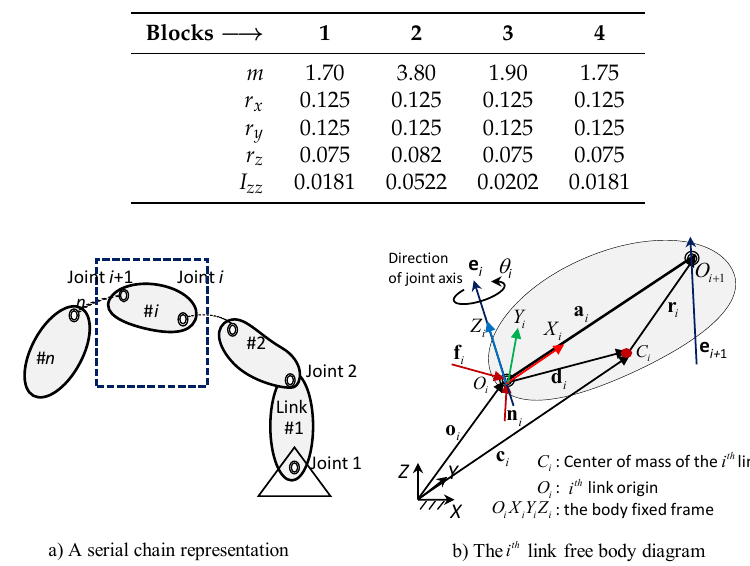
Table 3. The parameters r x , r y , r z are component of vector r , i.e., length from center O to center of mass (COM) C as in Figure 6, with dynamic parameters of m for mass (kg) and I for inertia (kgm 2 ) about the link COM.